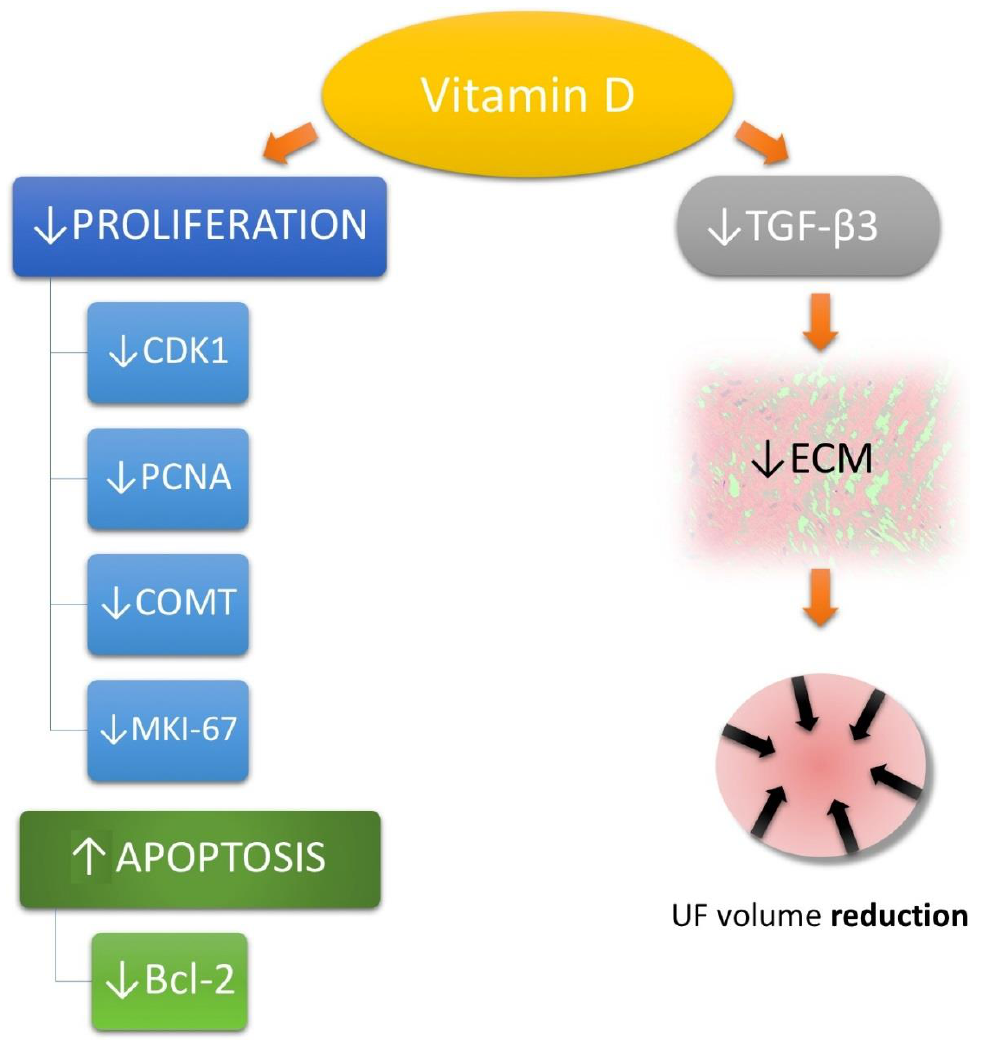
Figure 2. Vitamin D influence on uterine fibroid (UF) pathophysiological pathways. Cyclin-dependent kinase 1 (CDK1), proliferating cell nuclear antigen (PCNA), catechol- O -methyltransferase (COMT), Bcl-2 protein, proliferation marker protein Ki-67 (MKI-67), extracellular matrix (ECM), transforming growth factor beta 3 (TGF-β3), uterine fibroid (UF).